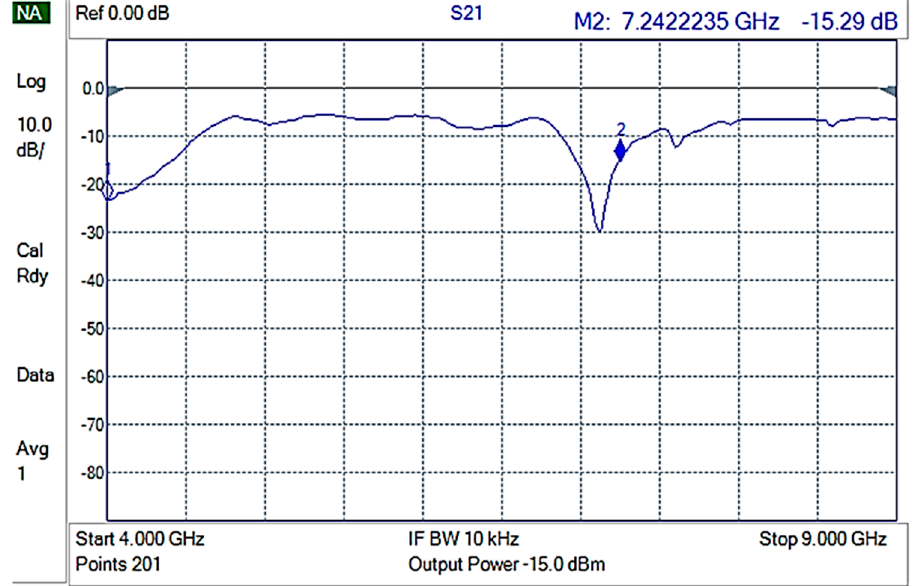
Figure 8. S21 for GNPV containing composite materials.